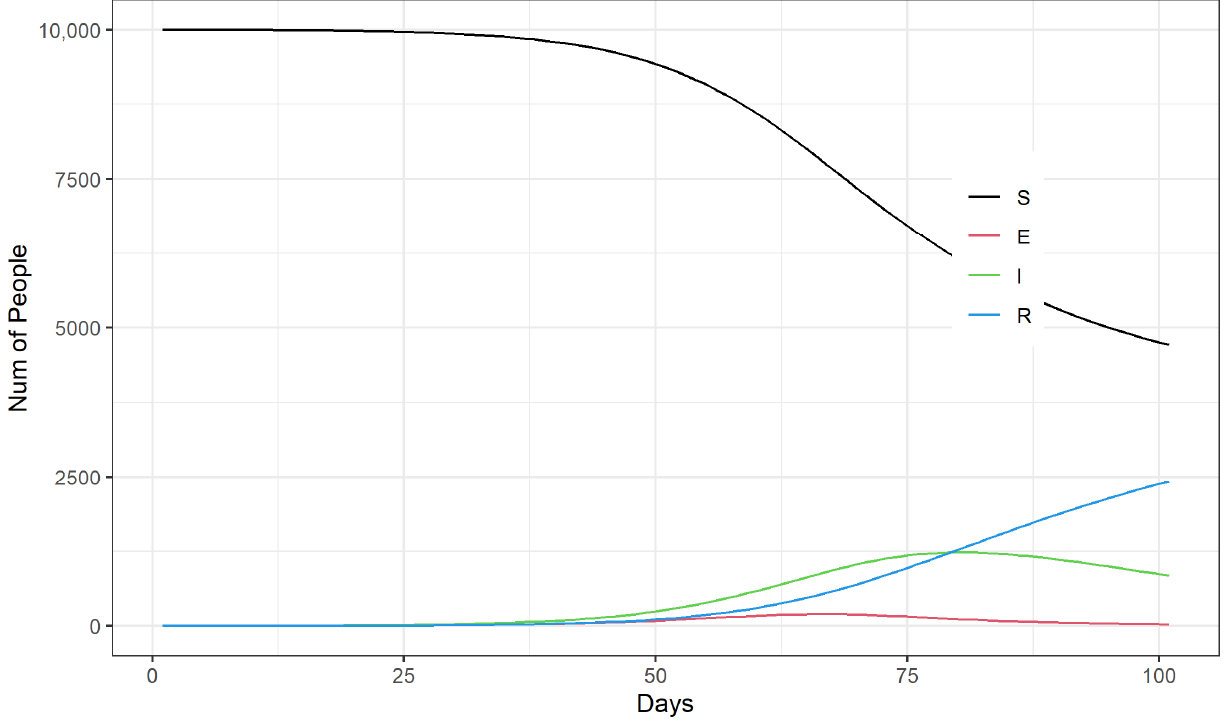
Figure A6. The influence of the daily testing capacity of 3000 person on the evolutionary process of the epidemic; (The unit of the ordinate is “person”).